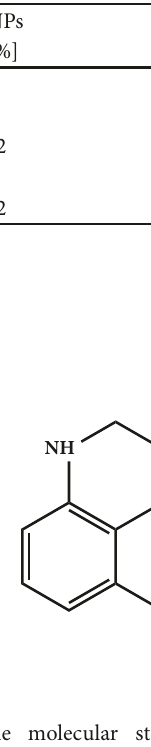
Table 1: Compositions of the Au-SiO 2 -ACAIN monomer composites.